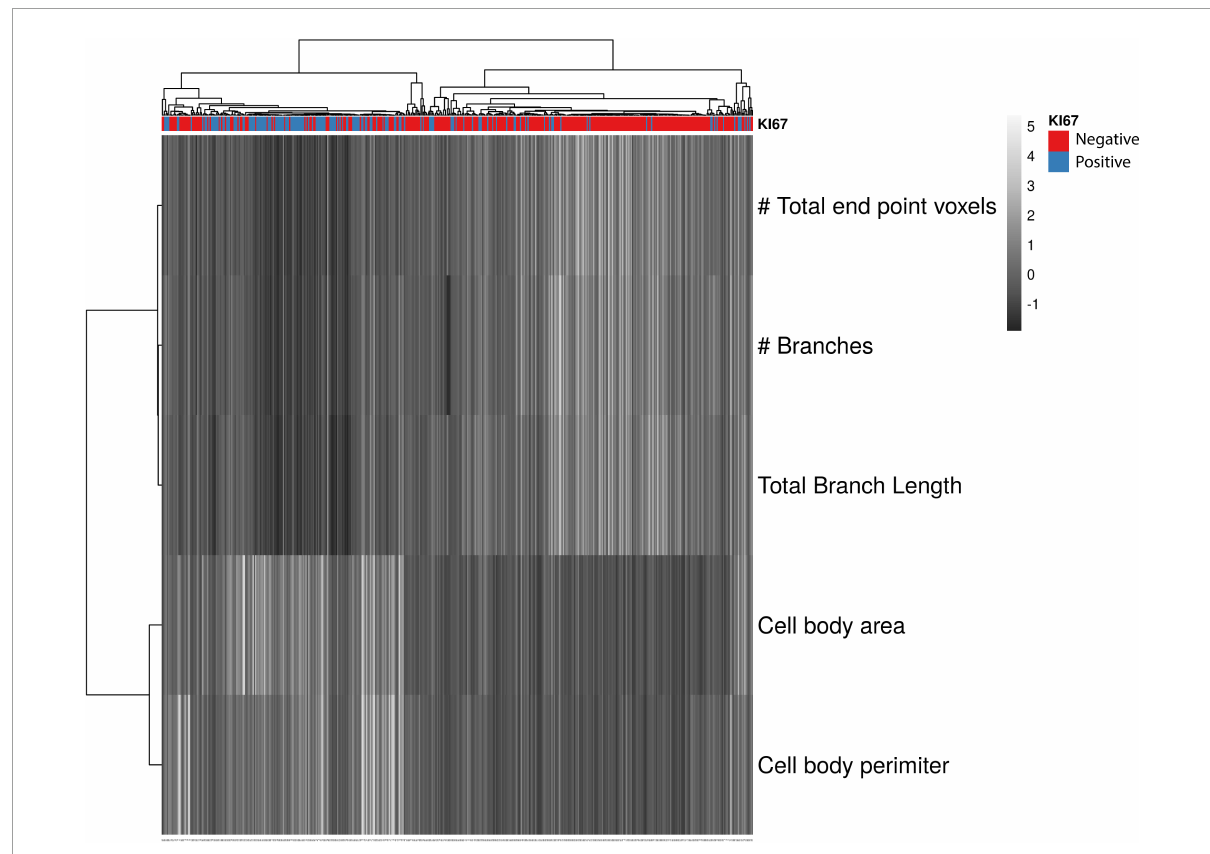
FIGURE6 Summary Figure showing that KI67 + microglia have a more reactive morphology than KI67– microglia. Heatmap showing branch and cell body data clustered using correlation distance and average linkage. Unit variance scaling was applied to all continuous variables. Columns represent individual microglial cells. A score of –1 (blue) denotes a lower number and a score of 5 a higher number in the respective row. The majority KI67 − microglia had higher scores for skeletal analysis measurements (endpoints/microglia, branches/microglia and total branch length/microglia) and lower scores for cell body area and perimeter. Most KI67 + cells (red) had lower scores for skeletal analysis measurements and higher scores for cell body area and perimeter, indicating that dividing microglia had less ramification and a larger cell body. TNF- α KO KI67 − n = 181 microglia; WT KI67 − n = 139 microglia; TNF- α KO KI67 + n = 87 microglia; WT KI67 + n = 71